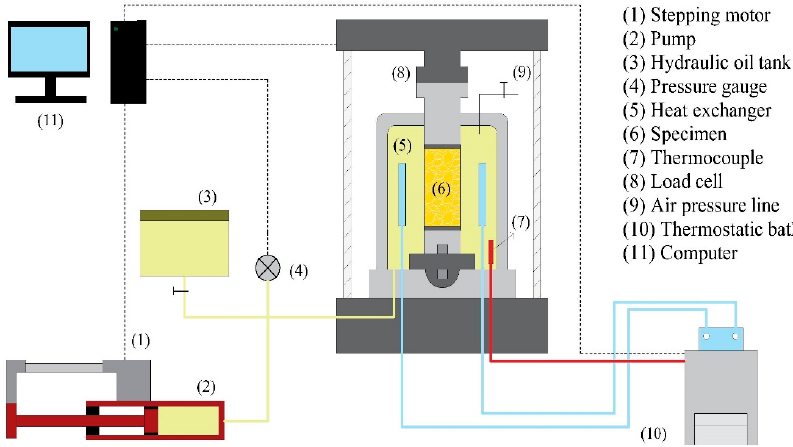
Figure 1. Schematic diagram of the triaxial testing system